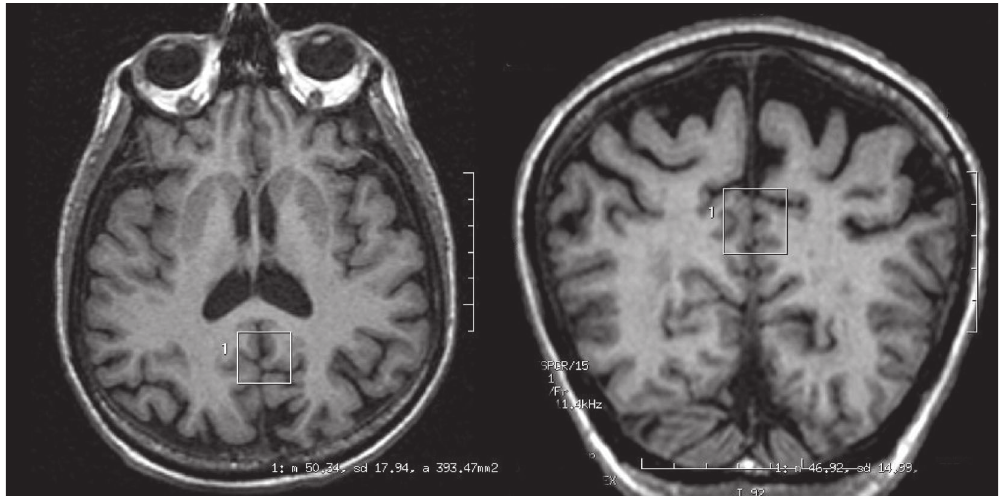
Figure 2. Representation of voxel in axial and coronal planes from volumetric images (SPGR).